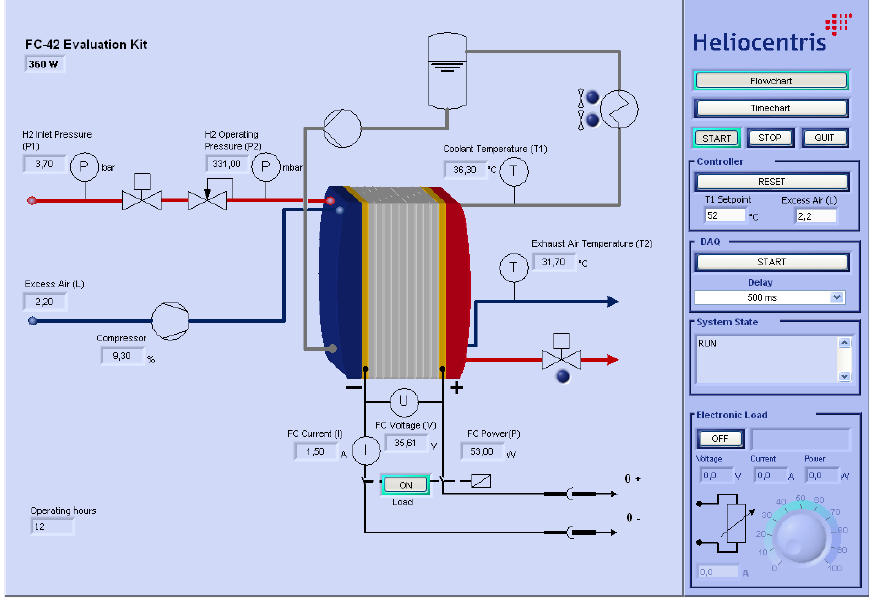
Figure 12. PEM fuel cell measuring system.